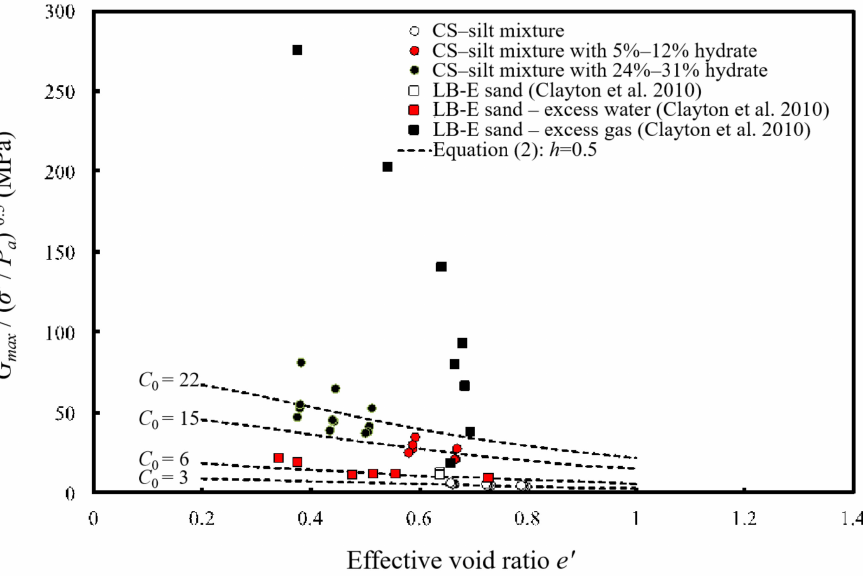
Figure 7. Relationship between the normalised maximum shear modulus and the effective void ratio